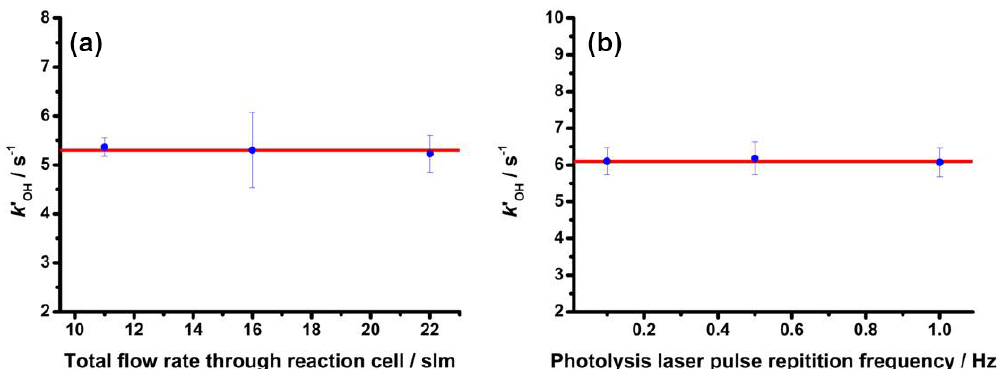
Figure 10. Observed OH reactivities for a fixed gas composition (for which the expected OH reactivity is shown in red) (a) as a function of the total flow rate through the reaction cell (slm = standard Lmin − 1 ) and (b) as a function of the pulse repetition frequency of the photolysis